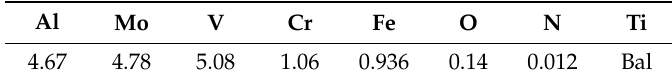
Table 1. Main chemical composition of TC18 titanium alloy (%) [23]. Table 2. Mechanical properties of TC18 titanium alloy [23].